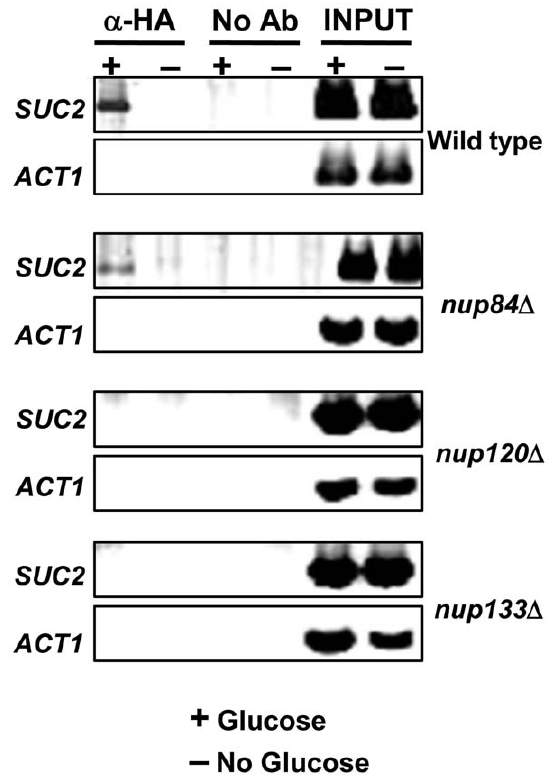
Figure 6. Mig1 fails to bind its target site in the SUC2 promoter in the absence of NUP120 or NUP133 . HA-tagged Mig1 ( a -HA) was immunoprecipitated from wild type (A), nup84 D (B), nup120 D (C), and nup130 D (D) cells grown in either the presence ( + ) or absence ( 2 ) of glucose. PCR was used to amplify the promoters of SUC2 and ACT1 (negative control) from immunoprecipitated material ( a -HA), no antibody negative control (No Ab), and whole cell extracts (Input).